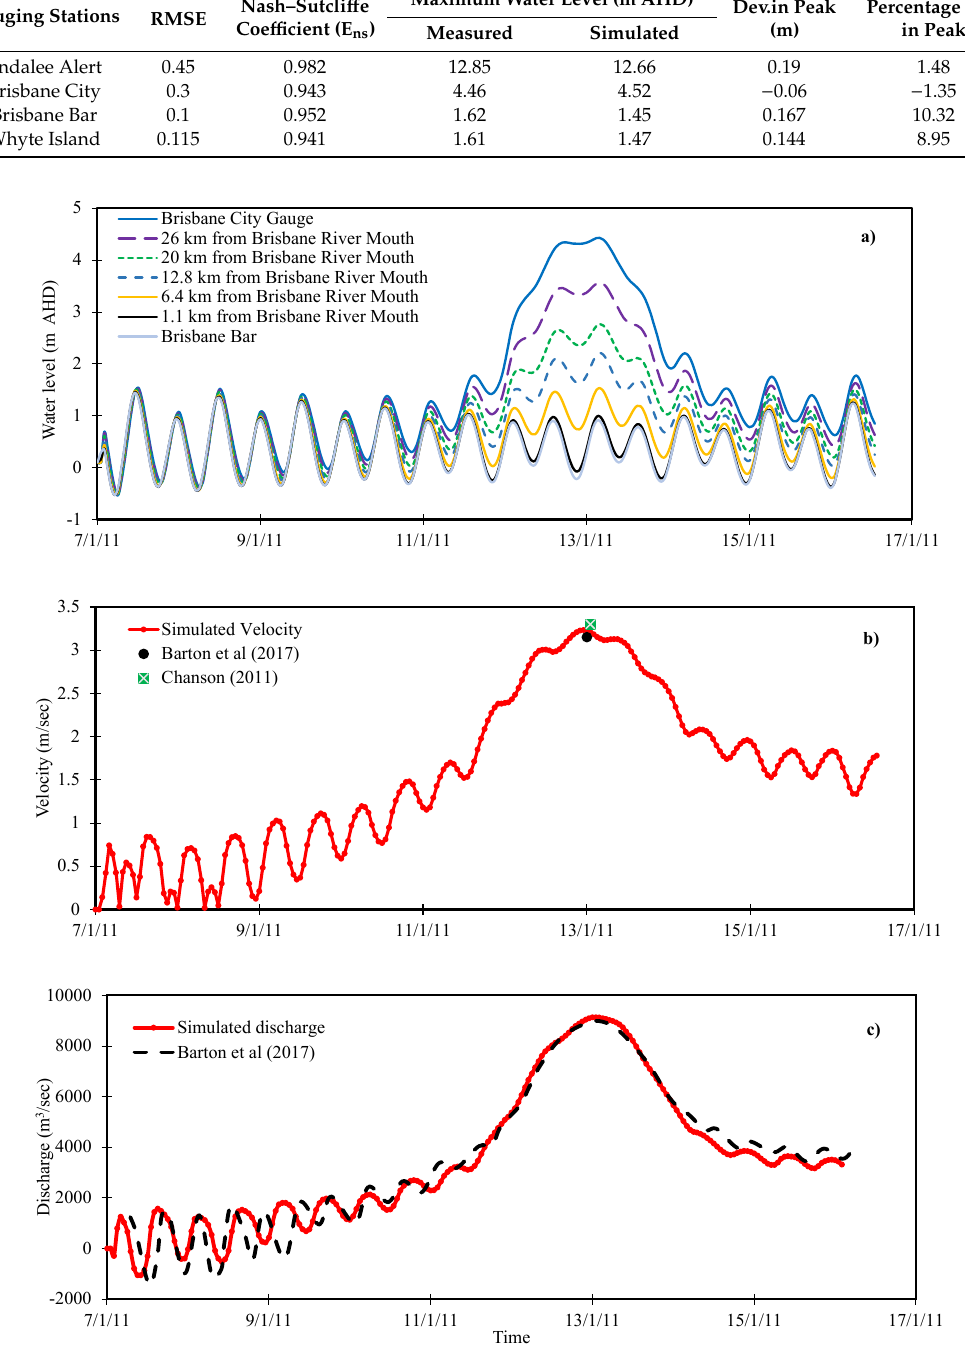
Figure 8. ( a ) Simulated water level for the 2011 flood in Brisbane River estuary from Brisbane city gauge to Brisbane Bar; ( b ) Simulated velocity for the 2011 flood in the BRE at Brisbane city gauge; ( c ) Simulated discharge for the 2011 flood in the BRE at Brisbane city gauge. Table 6. Performance indices at gauging stations during validation of the 2011 event.